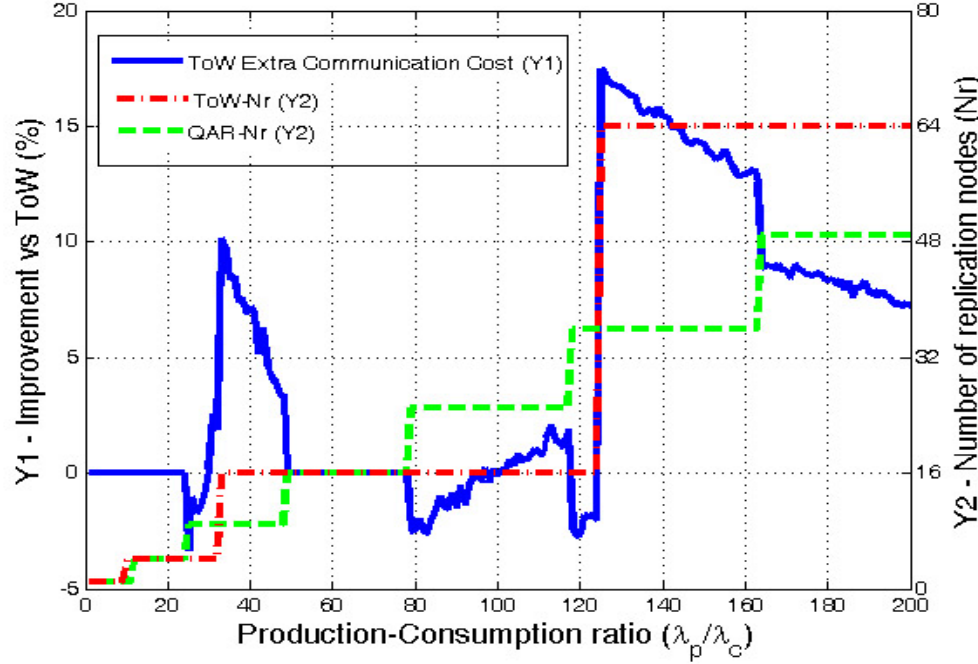
Figure 10. Extra communication cost produced by ToW in front of QAR when production dominates consumption in Y1 axis. Number of replicas used for each approach in Y2 axis (A = 1,000 × 1 , 000 , N = 5 , 000 , T x = 60 , Iterations = 100)